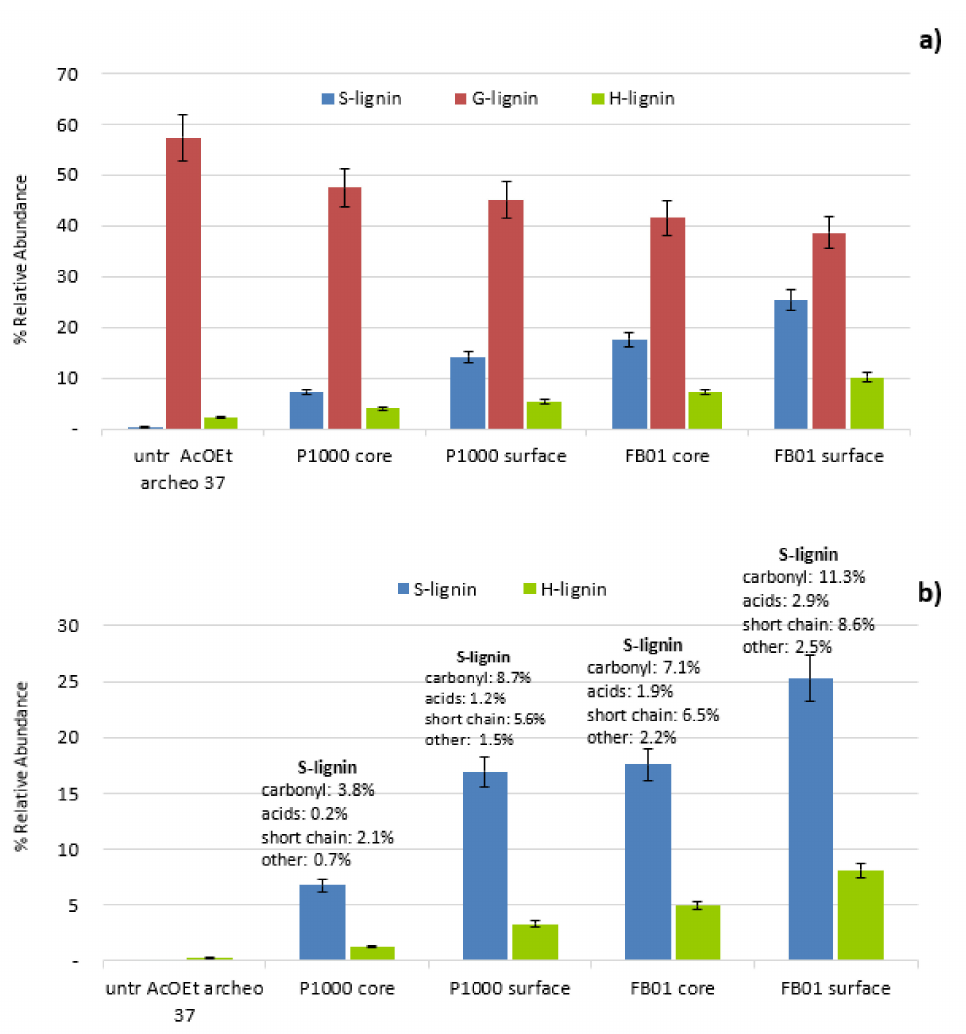
Figure 10. Distribution of ( a ) S-, G- and H-lignin units as percentages of lignin pyrolysis products identified in archaeological pine specimens treated with ethyl acetate (archeo AcOEt) and with P1000 and FB01 lignins, ( b ) S-lignin and H-lignin units as percentages of lignin pyrolysis products determined in P1000 and FB01 treated specimens are very low or absent in archaeological pine (products in red script in Table 2). Relative abundance is expressed as a percentage of total